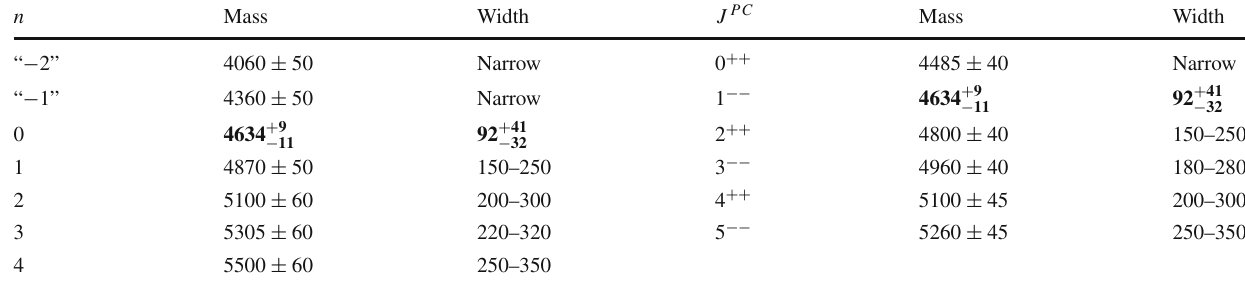
Table 11 Trajectories of the Y ( 4630 ) . Based on the experimental mass and width of the Y ( 4630 ) we extrapolate to higher excited states on the trajectory. Uncertainties are based on both experimental errors and uncertainties in the fit parameters. The excited states are expected to